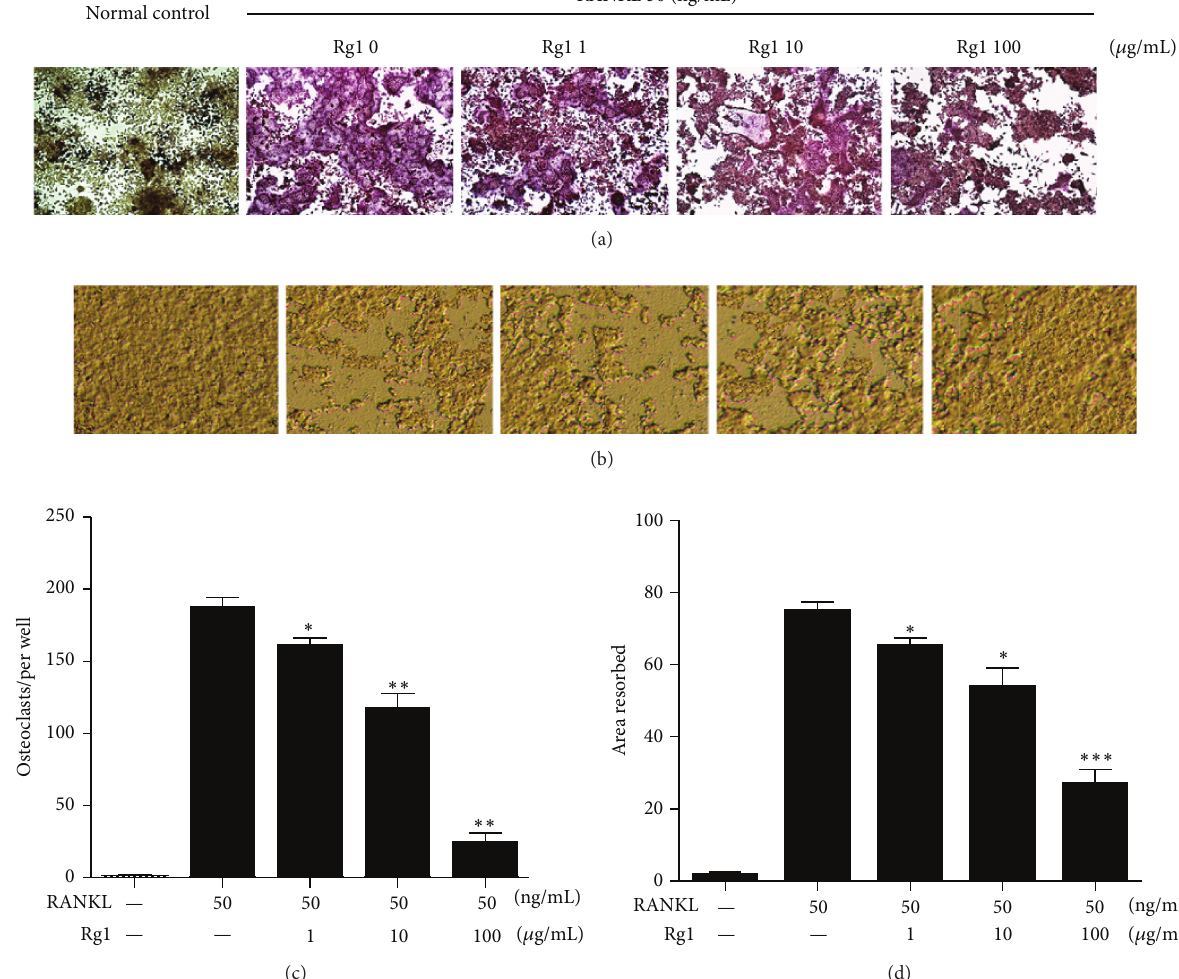
Figure 2: Effects of Rg1 on osteoclast differentiation and resorption pit formation in RANKL-stimulated RAW 264.7 cells. (a) RAW 264.7 cells (2 × 10 4 cells/mL) were stimulated with RANKL (100ng/mL) for 96 h with or without the presence of Rg1 (1, 10, and 100 𝜇 g/mL). Cells were fixed with 3.7% formalin, permeabilized with 0.1% Triton X-100, and stained with TRAP solution. (b) RAW 264.7 cells (5 × 10 3 cells/mL) were cultured on bone slices with various concentrations of Rg1 in the presence of RANKL (50ng/mL). After culturing for 10 days, the dentine slice was recovered from the culture and subjected to visualization of resorption pits. (c) The cells were stained for TRAP, and TRAP-positive multinuclear cells containing more than three nuclei were counted as multinucleated osteoclasts (mOCs). (d) The percentages of resorbed area were determined using Image-J software. Values are expressed as the mean ± SD of triplicate experiments. ∗ 𝑃 > 0.05 , ∗∗ 𝑃 < 0.01 , and ∗∗∗ 𝑃 < 0.001